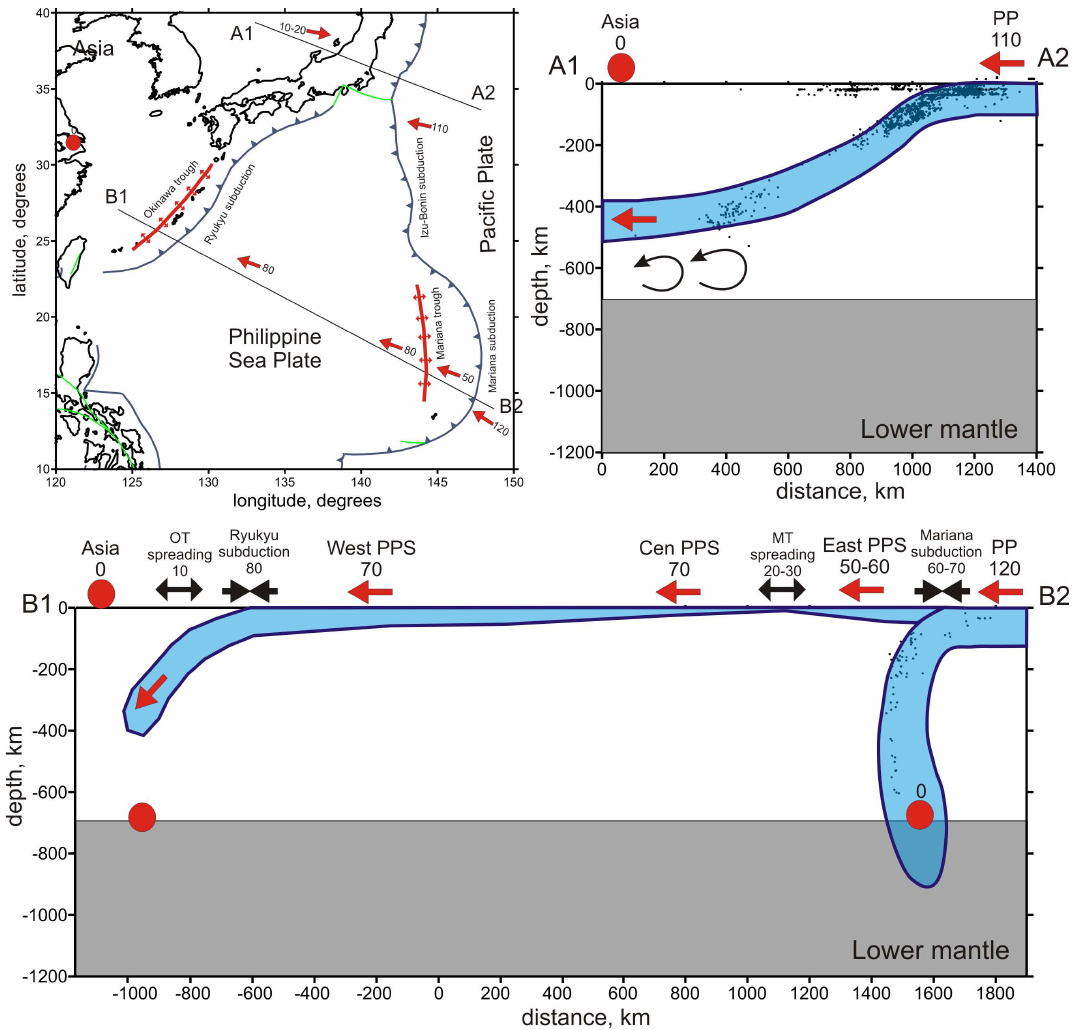
Fig. 10. Plate kinematics along two vertical profiles. Red circles indicate the locations where absolute velocities are close to zero. OT – Okinawa trough, PPS – Philippine Sea Plate, MT – Mariana trough, PP – Pacific plate. Relative divergence and convergence movements in spreading and subduction zones, respectively, are indicated with black arrows. Directions of absolute displacements are shown with red arrows and approximate rates are given in mmyr − 1 according to different sources (see the